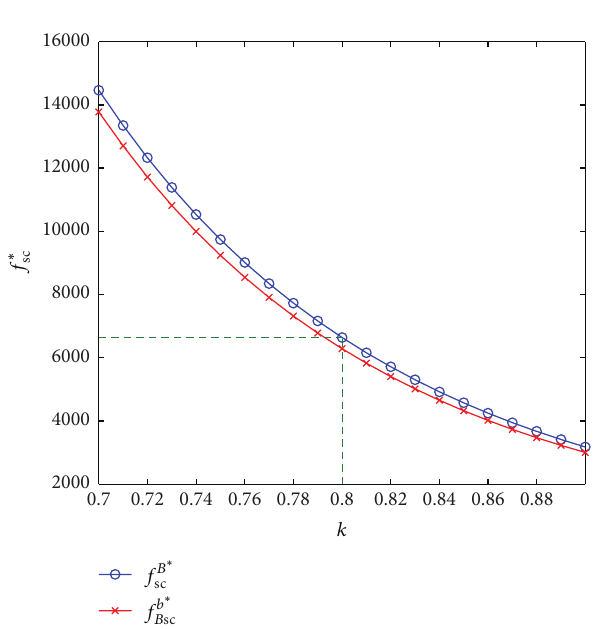
Figure 4: The profit of the supply